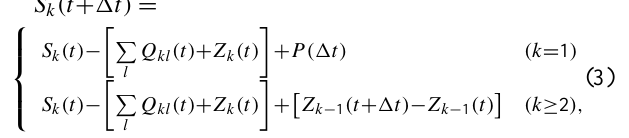
Figure 5. Scatter diagrams of NOPVI versus RAP and NOPVM versus NOPVI rainfall amounts. (a) and (c) show the maximum hourly rainfall amounts, (b) and (d) show the maximum daily rain- fall amounts. The number of grid counts computed by Eq. (1) is indicated by the color scale. Dots indicate grids corresponding to landslide